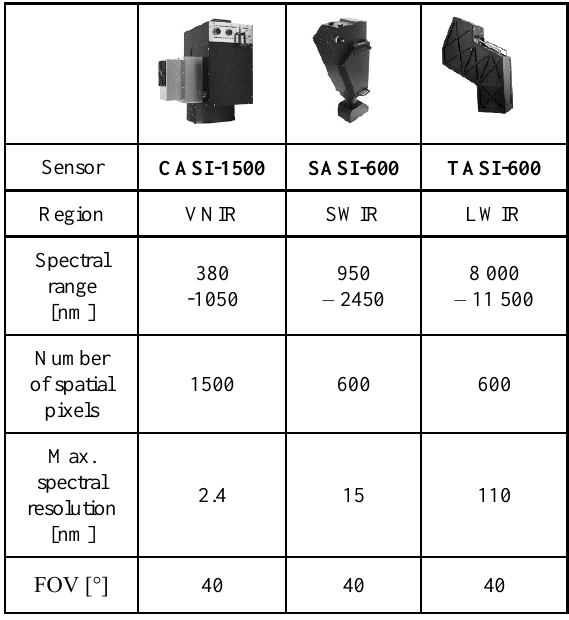
Table 1. Basic technical specifications of the FLIS hyperspectral system.